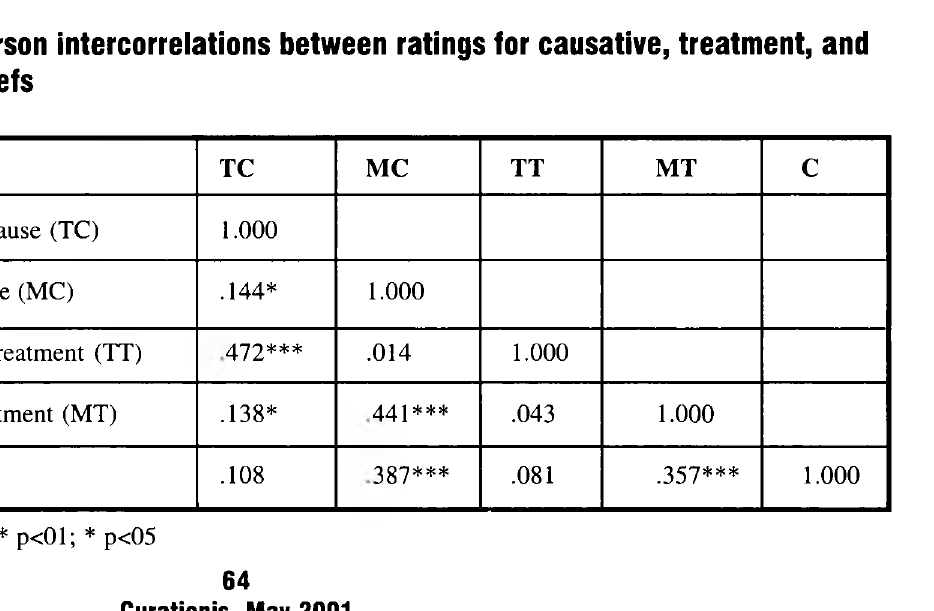
Table 4: Pearson intercorrelations between ratings for causative, treatm ent, and curative